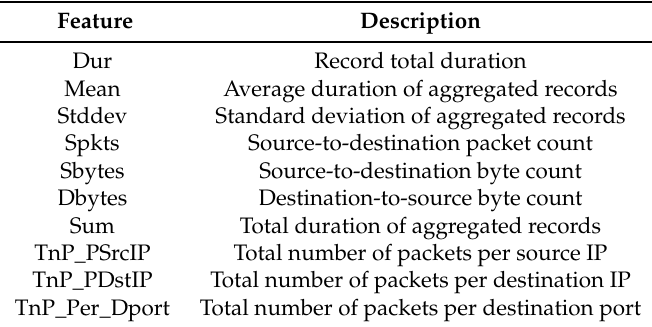
Table 7. 10 best features.